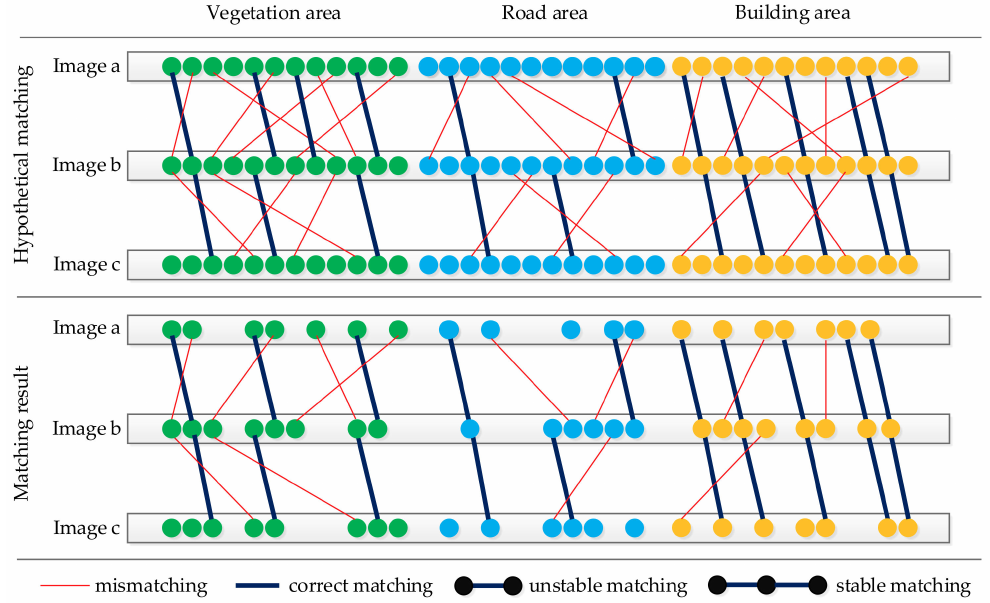
Figure 2. Limitations of the existing feature selection